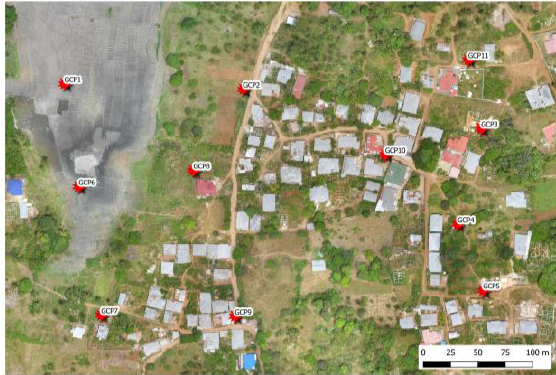
Figure 2: Distribution of GCPs for experimental test flights in Kibonde Mzungu (TZ). GCP ID 2 was used for processing scenario with only one GCP; GCP ID 1, 2, 5, 7, 10, 11 for processing scenarios with six GCPs.